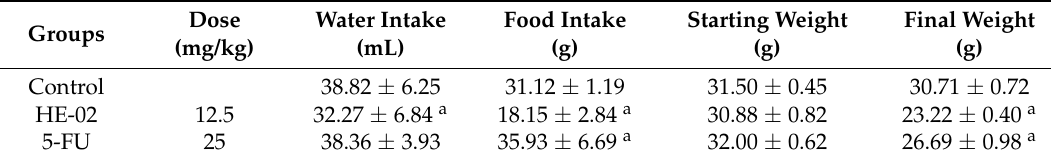
Table 2. Water and feed consumption and weight evolution of mice ( n = 6) subjected to different treatments (9 days).